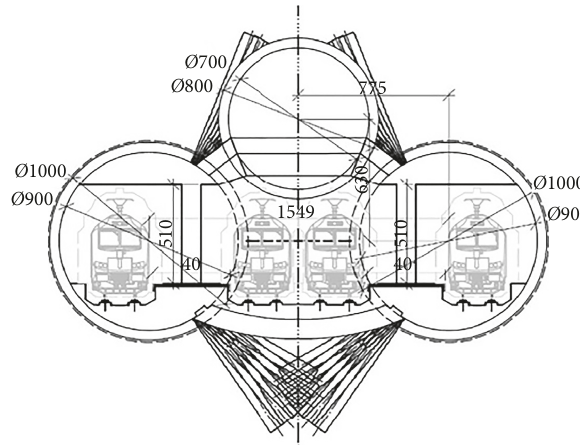
Figure 1: Proposed triplet configuration (dimensions in cm) (Schotte et al.